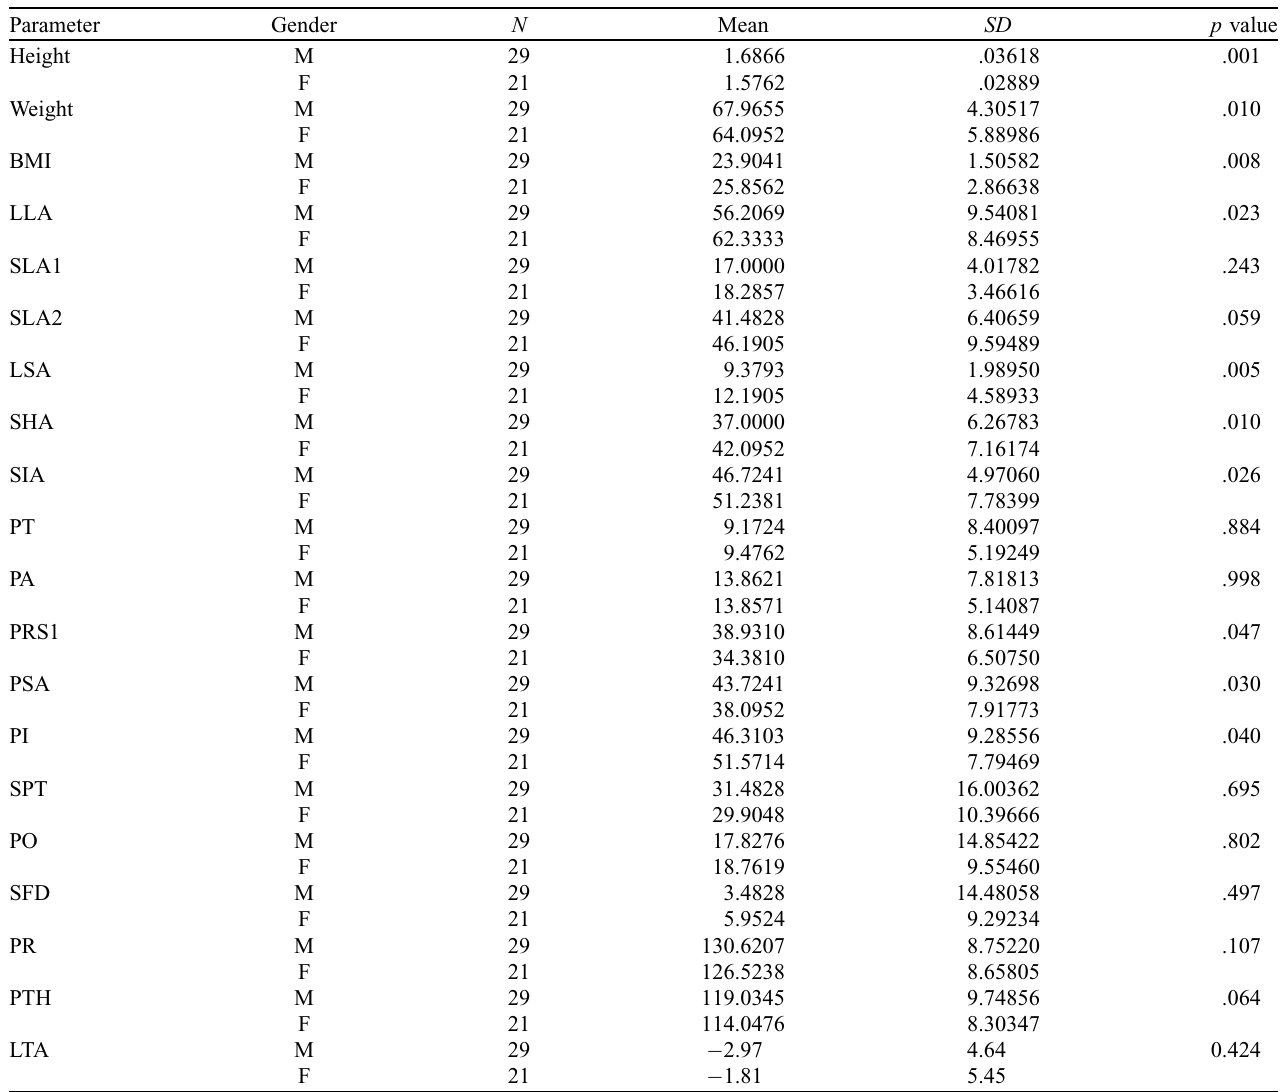
Table 3. Pelvic and spinal parameters according to sex.